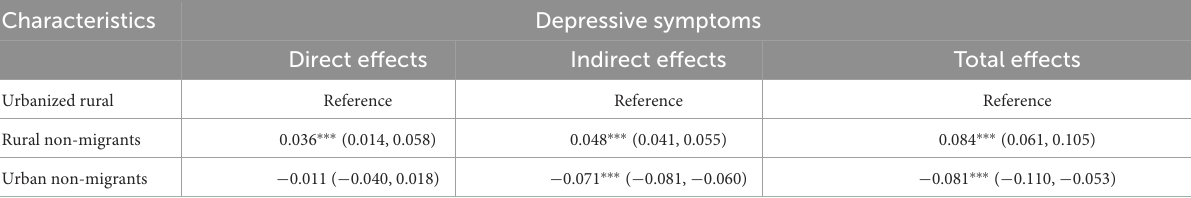
TABLE 3 Direct effect, indirect and total effect of residential status on depressive symptoms ( N =